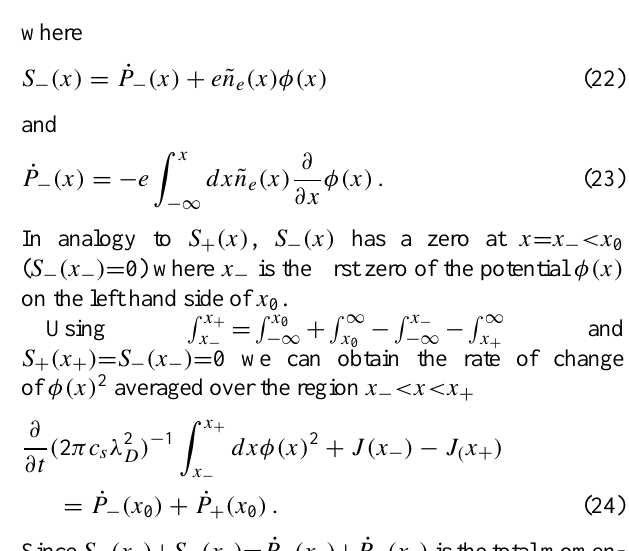
Figure 2: The positions x + and x - related to the zeroes of momentum input. Fig. 2. The positions x+ and x- related to the zeroes of momentum